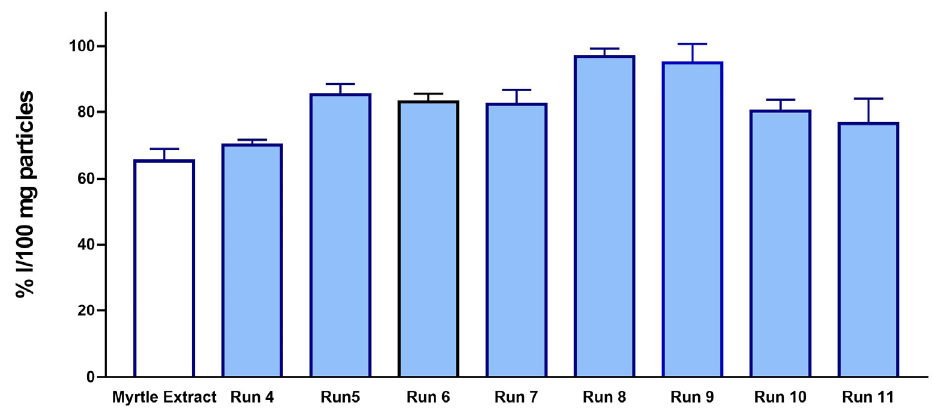
Figure 7. Antioxidant activity of processed particles.